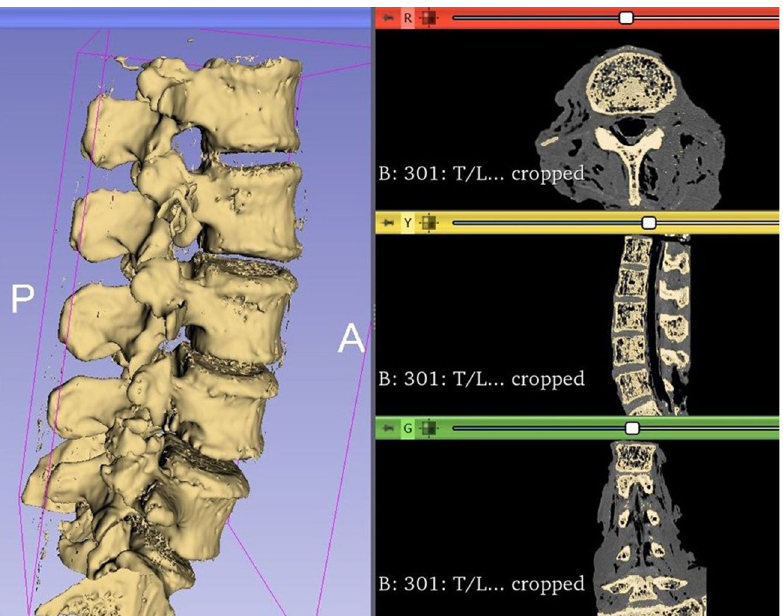
Figure 2. Example of 3D segmentation of the lumbar spine using 3D Slicer. Each vertebra file was saved as an individual file.